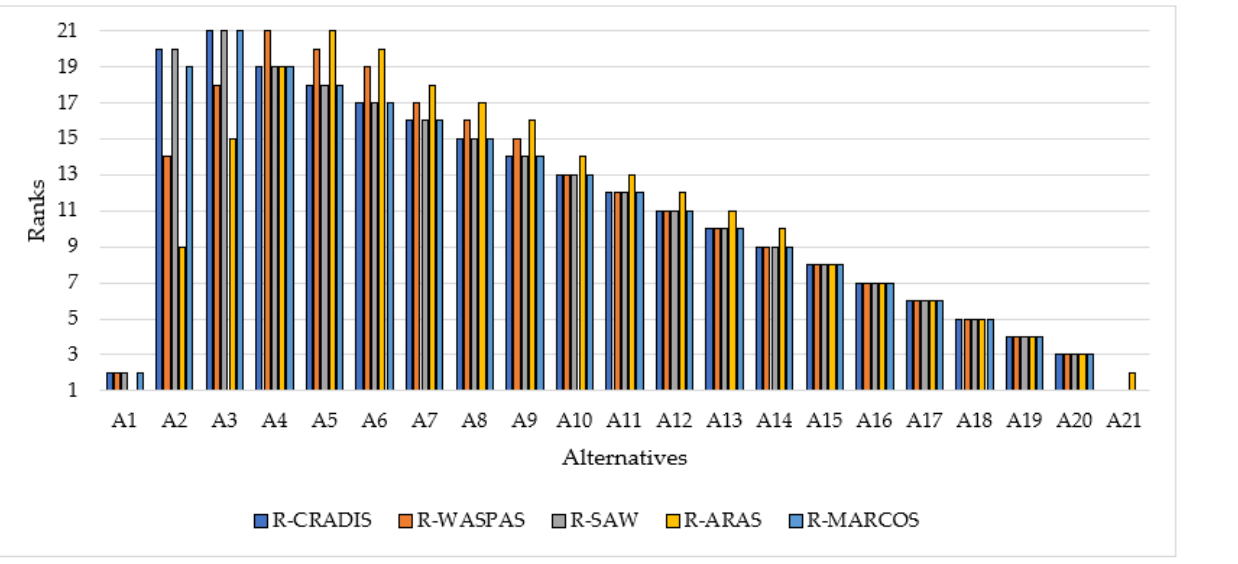
Figure 6. Comparison results of R-CRADIS with four Rough MCDM methods.